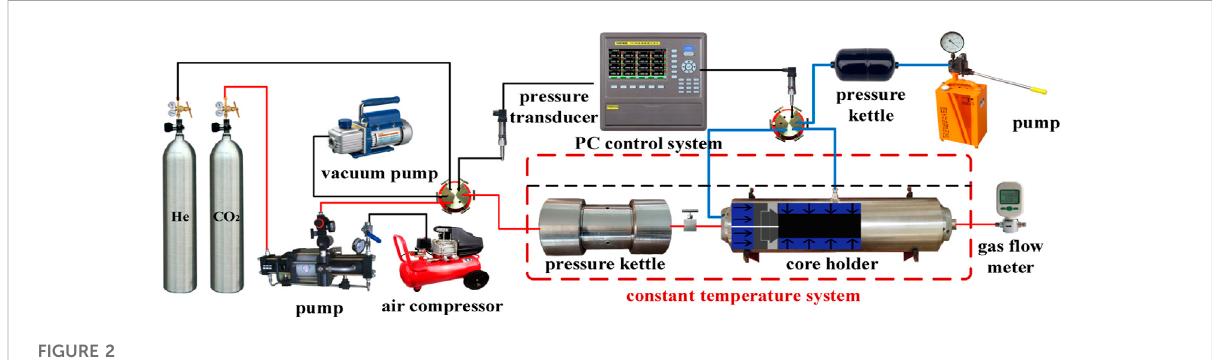
FIGURE 2 Permeability experimental